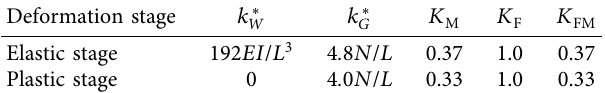
Figure 6: Simplified model of the equivalent SDOF system considering axial force. Table 4: Equivalent characteristic parameters.